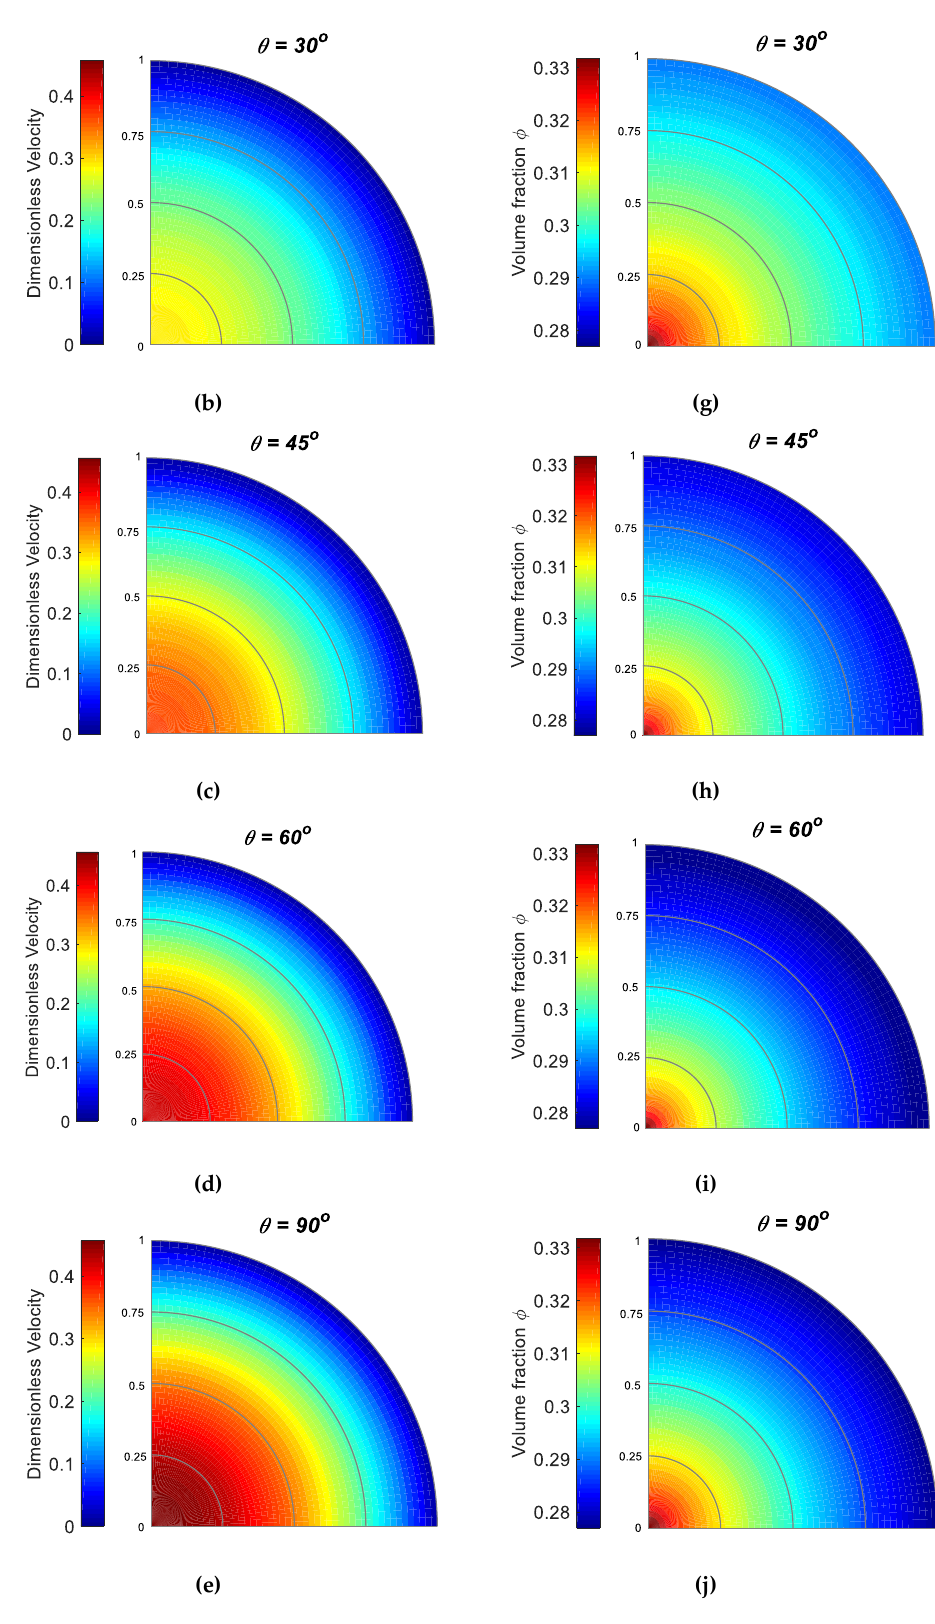
Figure 8. Distribution of the velocity for ( a ) θ = 0 ◦ ; ( b ) θ = 30 ◦ ; ( c ) θ = 45 ◦ ; ( d ) θ = 60 ◦ ; ( e ) θ = 90 ◦ ; and the cement volume concentration for ( f ) θ = 0 ◦ ; ( g ) θ = 30 ◦ ; ( h ) θ = 45 ◦ ; ( i ) θ = 60 ◦ ; ( j ) θ = 90 ◦